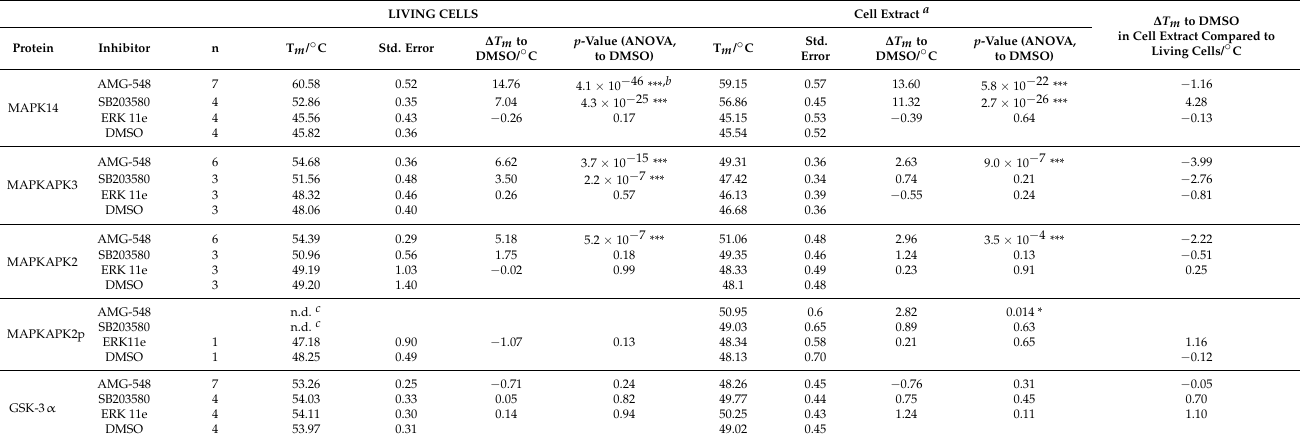
Table 1. Melting curve data of the CETSA experiments shown in Figure 1 (n: number of replicates). Thermal shifts induced by the inhibitors are reported as ∆ T m to DMSO as the vehicle